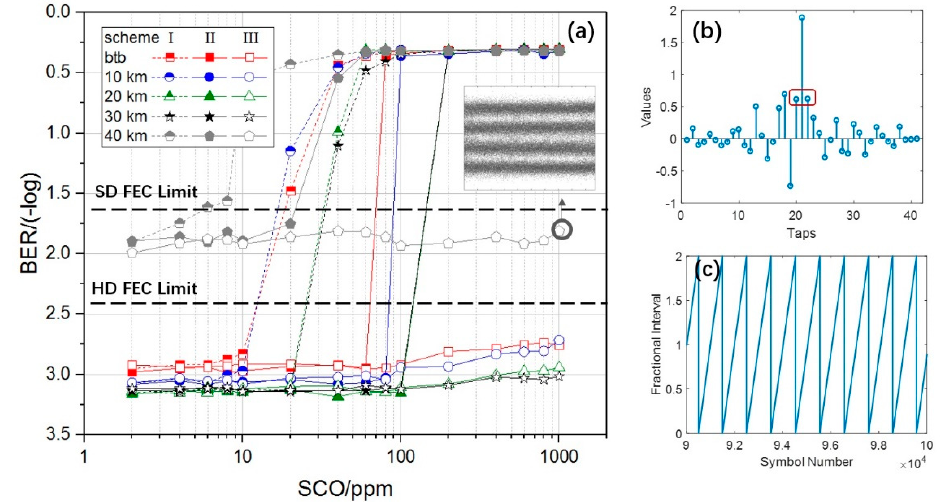
Figure 14. ( a ) The BER performance vs. sampling clock offset at received optical power of –8 dBm for 50 Gbps PAM4 signal; ( b ) the tap weights and ( c ) fractional interval of proposed CR-FFE after 40 km transmission when sampling clock offset is 1000 ppm (reprinted from [39] with open access from OSA).